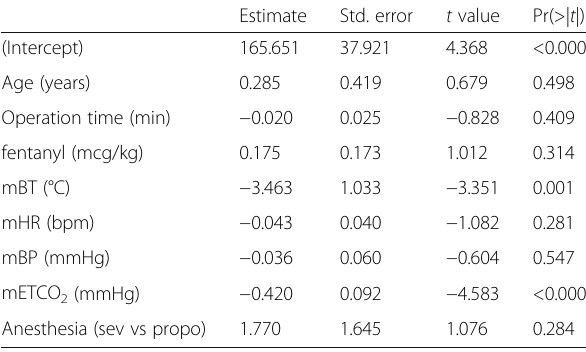
Table 2 Results of multiple regression analysis for clinical factors related to time to tracheal extubation Estimate Std.